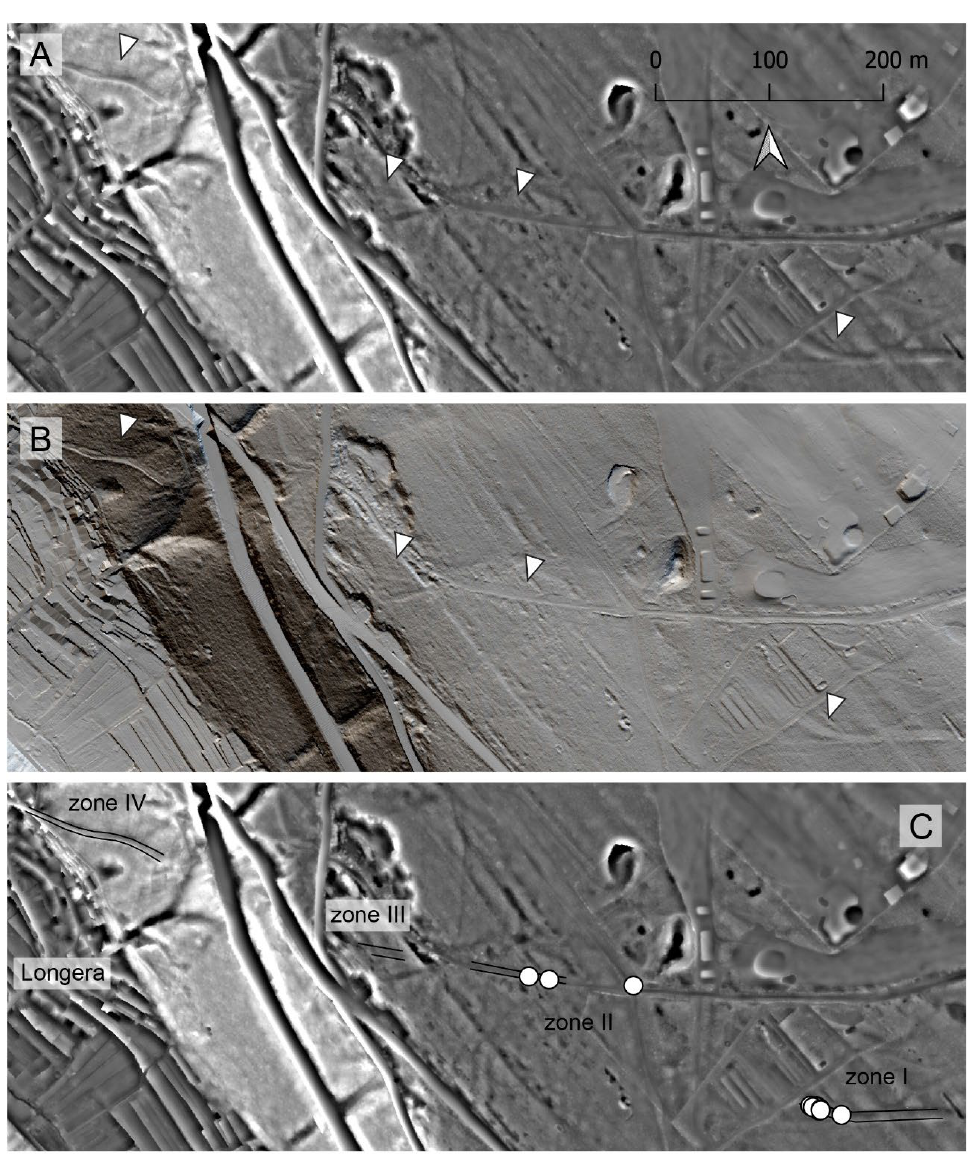
Figure 12. Zoomed view of area G of Figure 2 with the position of road tracks indicated by white arrows in pictures ( A ) (local relief model of an ALS-derived DTM) and ( B ) (hill-shaded image of an ALS-derived DTM) and by black lines in picture ( C ) (again a local relief model of the area). White circles: caliga hobnails.